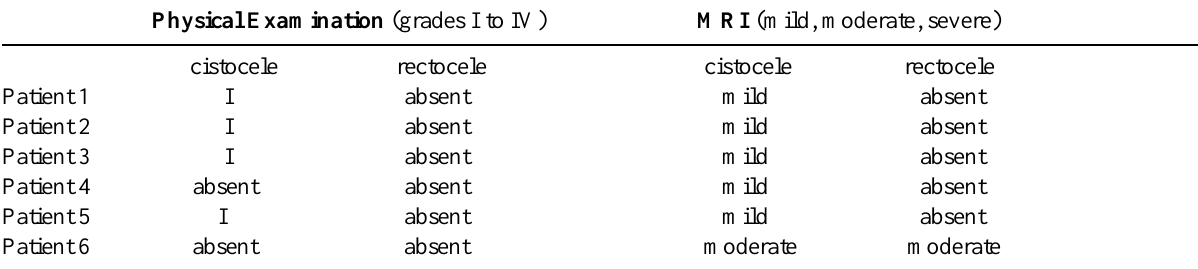
Table 2 – Pelvic organ prolapse